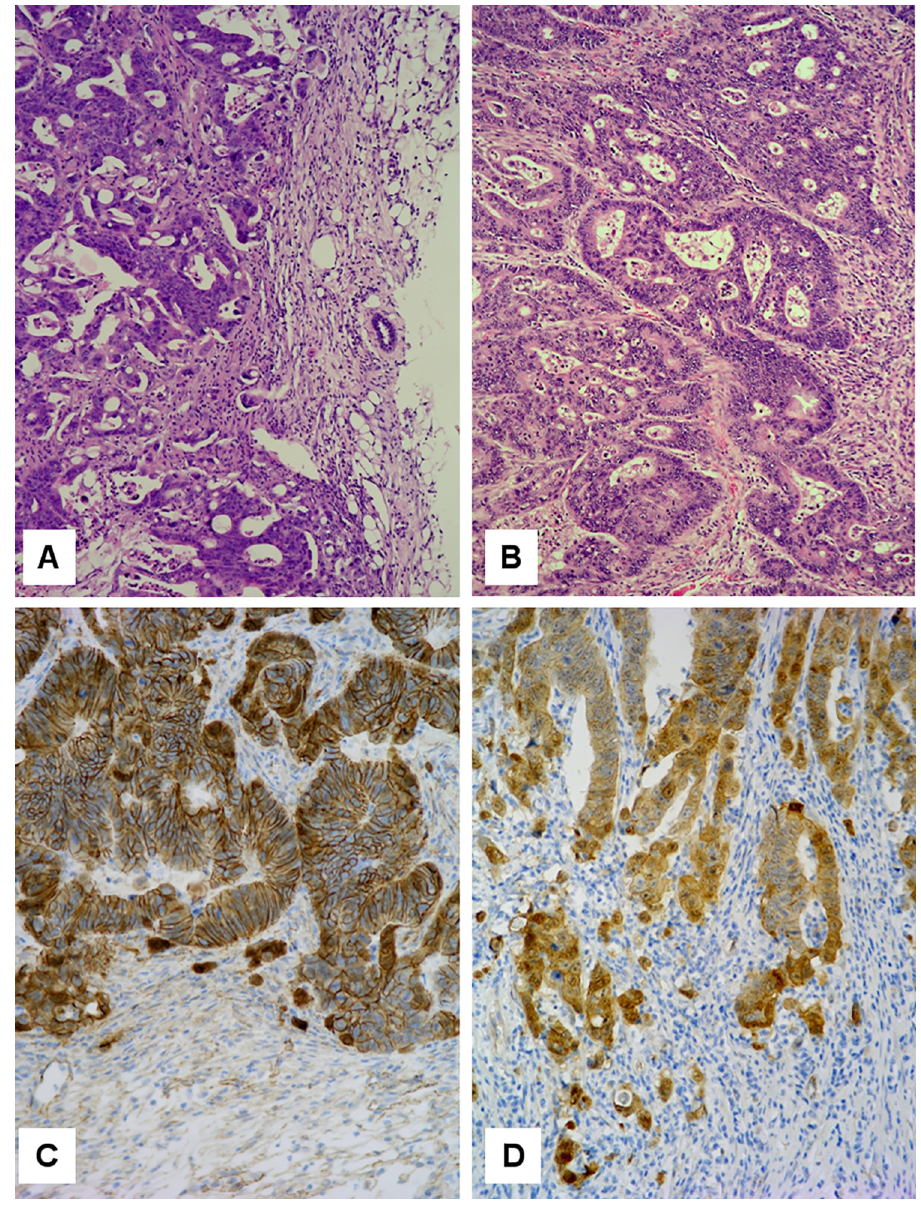
Fig 1. Tumor histology. H & E sections of ( A ) HROC40-PDX and ( B ) its primary. Note the invasive edge towards the right. Principal morphological features are retained in the PDX. β -catenin immunohistochemistry of ( C ) HROC60-PDX and ( D ) its primary. Note nuclear β -catenin translocation at the invasive edge of both